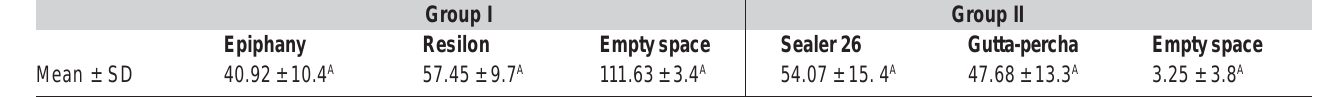
Table 2 – Percent means standard deviation (SD) for the number of points occupied by sealer, gutta-percha or Resilon and occasional empty